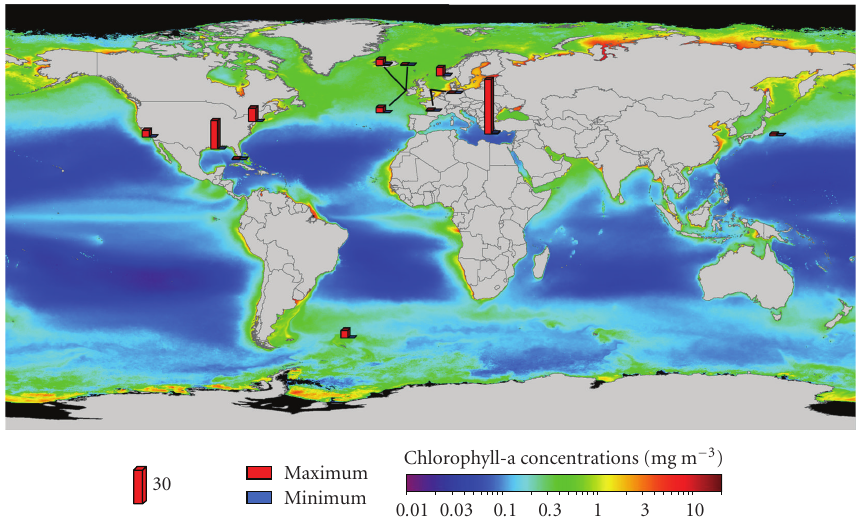
Figure 2: Marine Isoprene Flux Measurements and Estimates. Fluxes reported as × 10 8 molecules/cm 2 /sec. Otherwise as for Figure